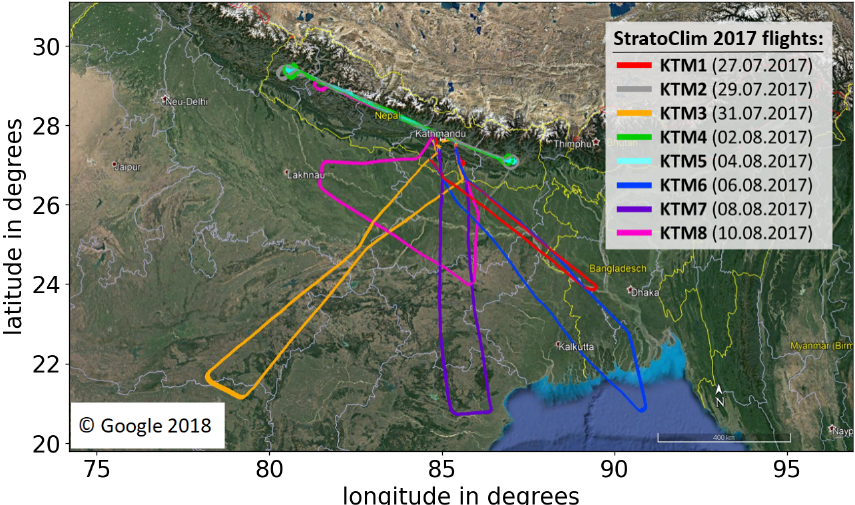
Figure 1. All flight paths of the mission flights conducted in Kathmandu (Nepal) as part of the StratoClim 2017 measurement campaign. GPS data from UCSE, © Google Earth